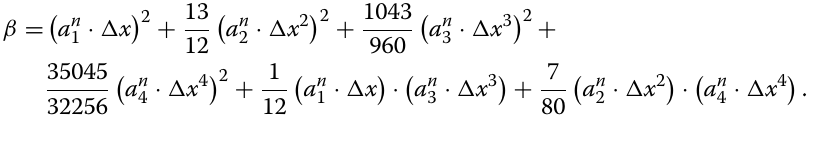
depends solely on the high-order gas evolution model at a cell interface, which keeps and traces flow dynamics as close as possible to a real physical time evolution